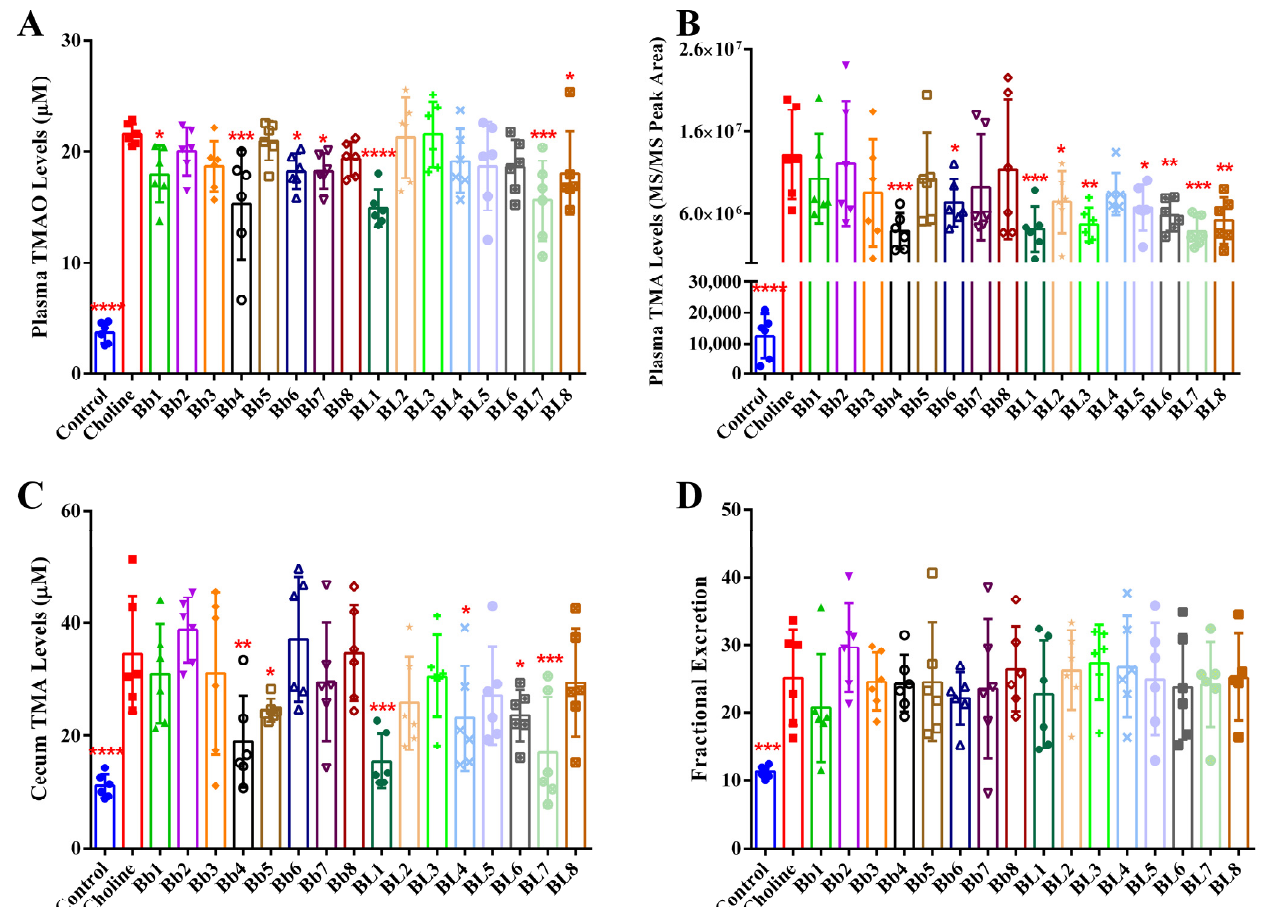
Figure 4. Some Bifidobacterium strains decreased the levels of plasma TMAO, plasma TMA and cecal TMA in mice to some extent: levels of ( A ) plasma TMAO, ( B ) plasma TMA, ( C ) cecal TMA; ( D ) fractional excretion of TMAO. Values are mean ± SD, six mice per group. * p < 0.05, ** p < 0.01, *** p < 0.001, **** p < 0.0001 versus the choline group.